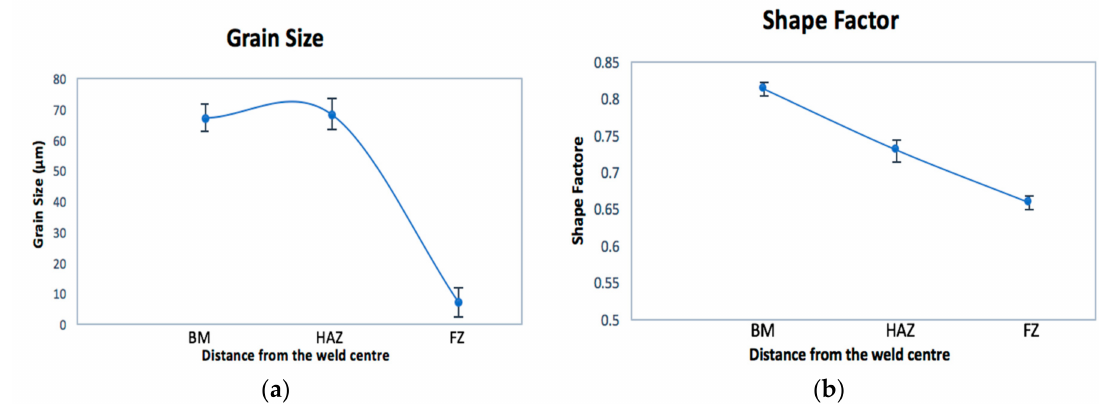
Figure 5. ( a ) Graph of grain size as a function of position, ( b ) Graph of shape factor against